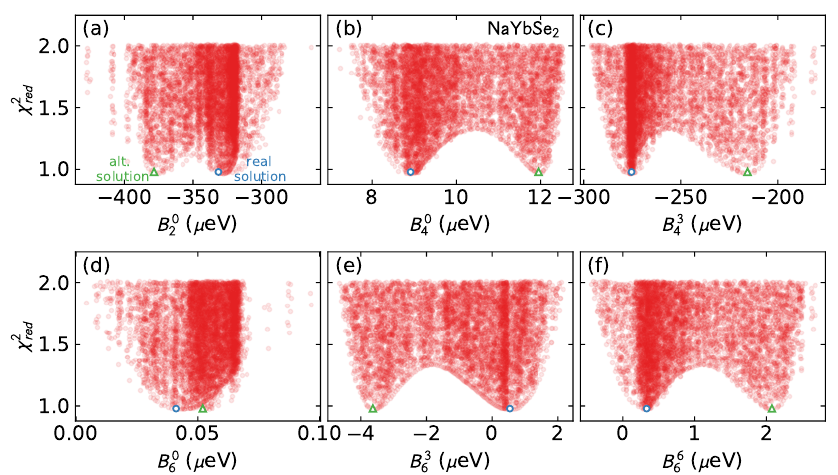
Figure 4: χ 2 for the simulated NaYbSe data in Fig. 3. Each red point is a solution 2 red within ∆ χ 2 < 1, and each panel shows a fitted CEF parameter. The “real” solution is shown with the small blue circle, while the small green triangle shows an alterna- tive solution with different anisotropy. Thus the fit is underdetermined by neutron scattering alone.